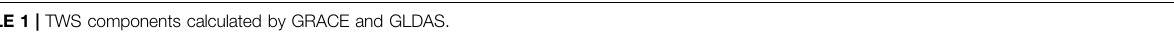
TABLE 1 | TWS components calculated by GRACE and GLDAS.